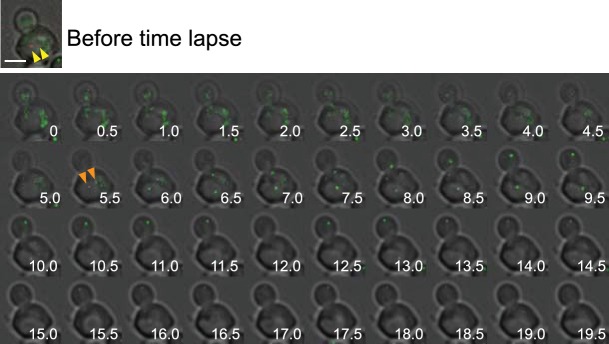
Time-lapse microscopy of SPC72-GFP cells.Time-lapse microscopy of SPC72-GFP MPS3-mRFP cells (HPH1394) as in Figure 4C. Images were taken every 30 s. RFP signal was capture only before staring the time-lapse series. Anaphase onset judged by sudden spindle elongation was observed at the 6.5 min timepoint. Spindle orientation was corrected between 5.5 min and 6.5 min timepoints. Yellow arrowheads indicate the position of Mps3-mRFP before the image capture. Orange arrowheads indicate the first appearance of Spc72-GFP signals at SPBs. Shown are deconvolved and projected images. Scale bar, 2 µm.